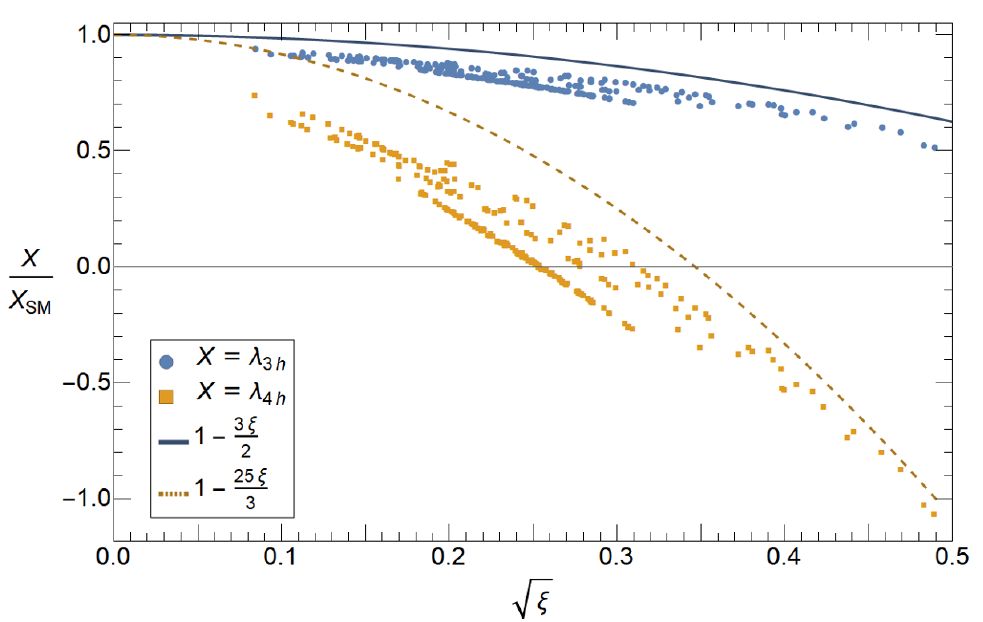
the BP of our model. We show the analytical approximations for them: in blue continuous line for the trilinear self-coupling, and in orange dashed line for the quartic